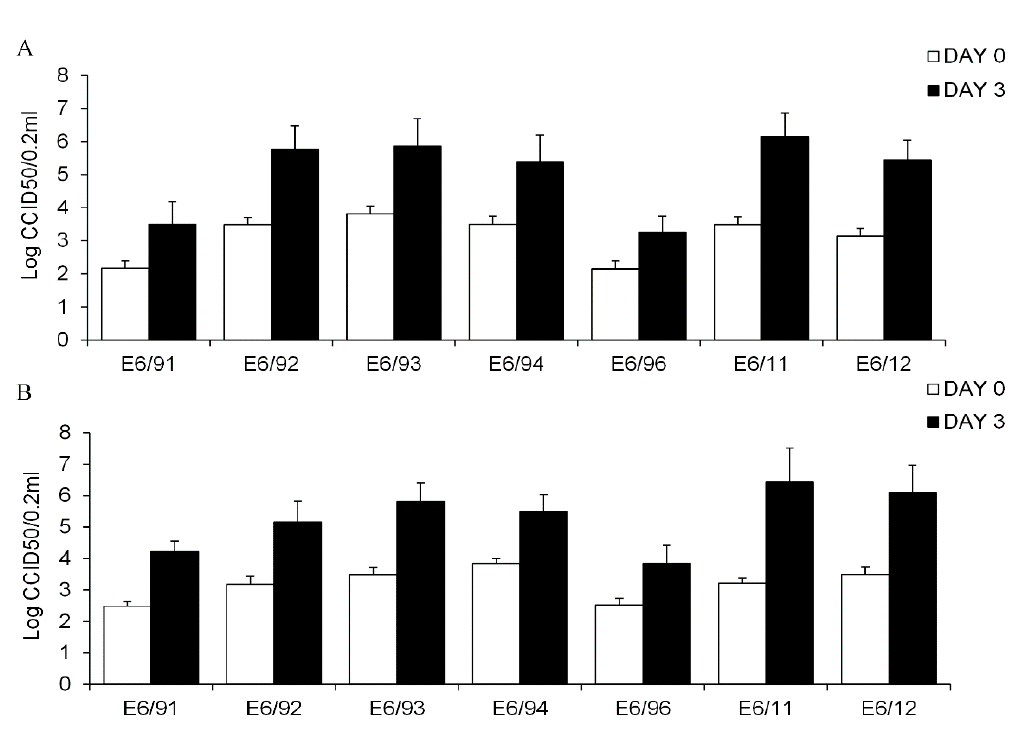
Figure 1. Replication of field strains of echovirus 6 (E6) in primary human exocrine cells ( A ) and into the islets ( B ). Free-floating human exocrine cells derived from ten donors and islets from seven donors were infected with a 1000 50% cell culture infectious dose (CCID50)/0.2 mL of E6/91, E6/92, E6/93, E6/94, E6/96, E6/11 and E6/12. The samples were taken at day 0 (empty bar) and day 3 (filled bar) post-infections and were assayed for total infectivity by using the CCID50 titration method. Data are presented as log10 (CCID50/0.2 mL), means ± standard deviation (SD) from experiment performed in triplicate.